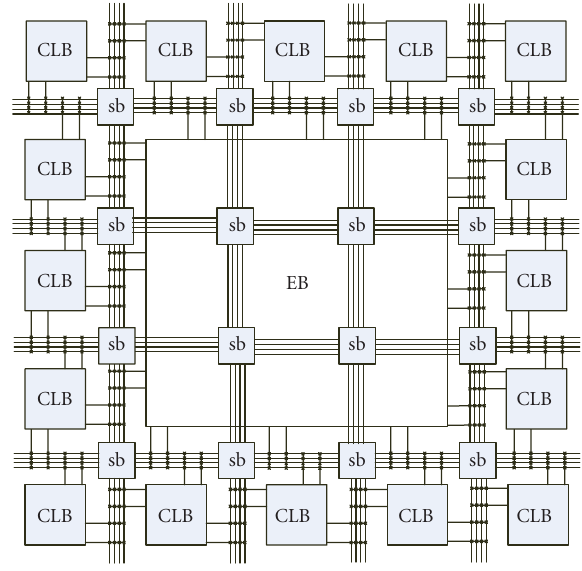
Figure 3: Connection between coarse- and fine-grained units through switch box